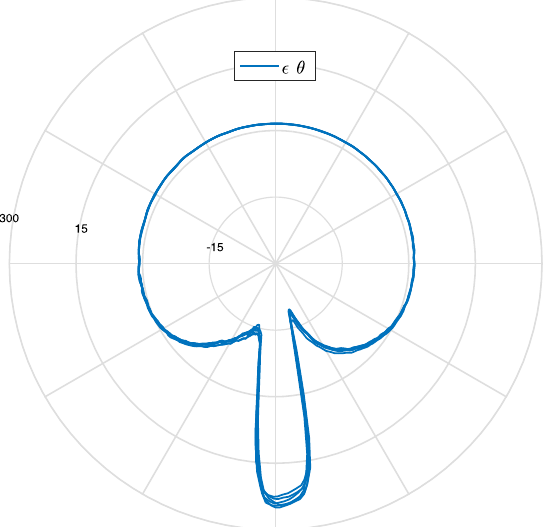
Figure 18. Polar plot of circumferential strain ( 𝜇 𝑠𝑡𝑟𝑎𝑖𝑛 ) as function of the wheel rotation angle ( 𝜃 ).